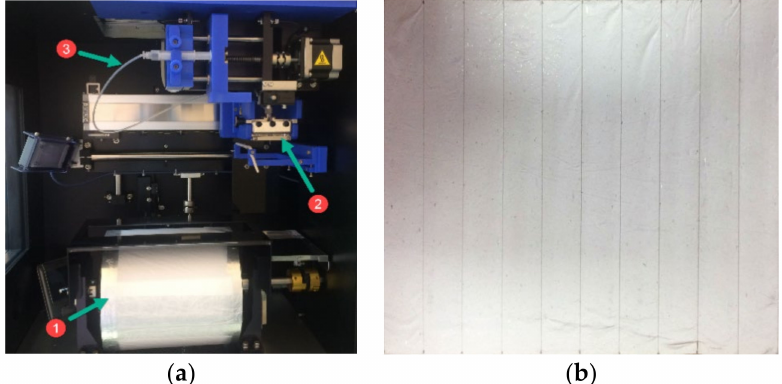
Figure 2. Nanofiber mat obtained by electrospinning process: ( a )—electrospinning system (1—rotating drum collector; 2—spinneret; 3—a syringe and a Teflon tube were used to supply the solutions); ( b )—sample for tensile testing.